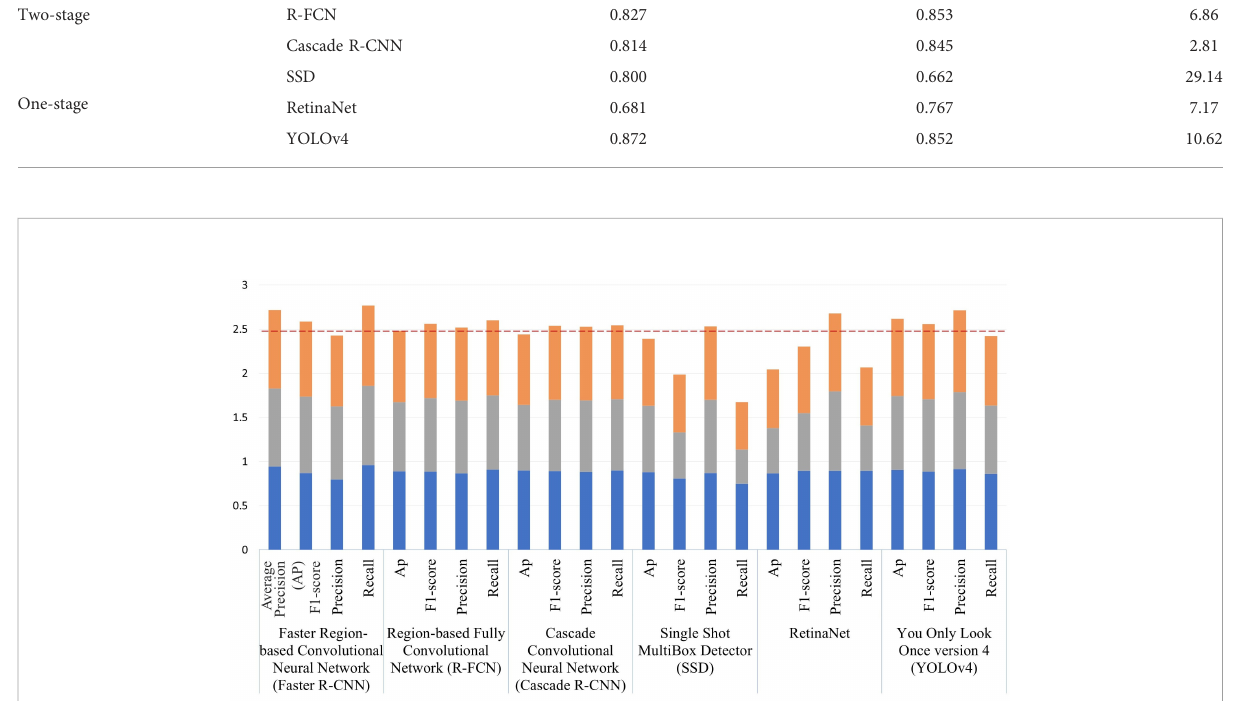
FIGURE 4 Detection accuracy of six different Deep-learning (DL) models using three datasets. The red dashed line is the mean (2.448) of the sum of the Average Precision (AP) of six DL models: Faster Region-based Convolutional Neural Network (Faster R-CNN), Region-based Fully Convolutional Network (R-FCN), Cascade Convolutional Neural Network (Cascade R-CNN), Single Shot MultiBox Detector (SSD), You Only Look Once version 4 (YOLOv4).